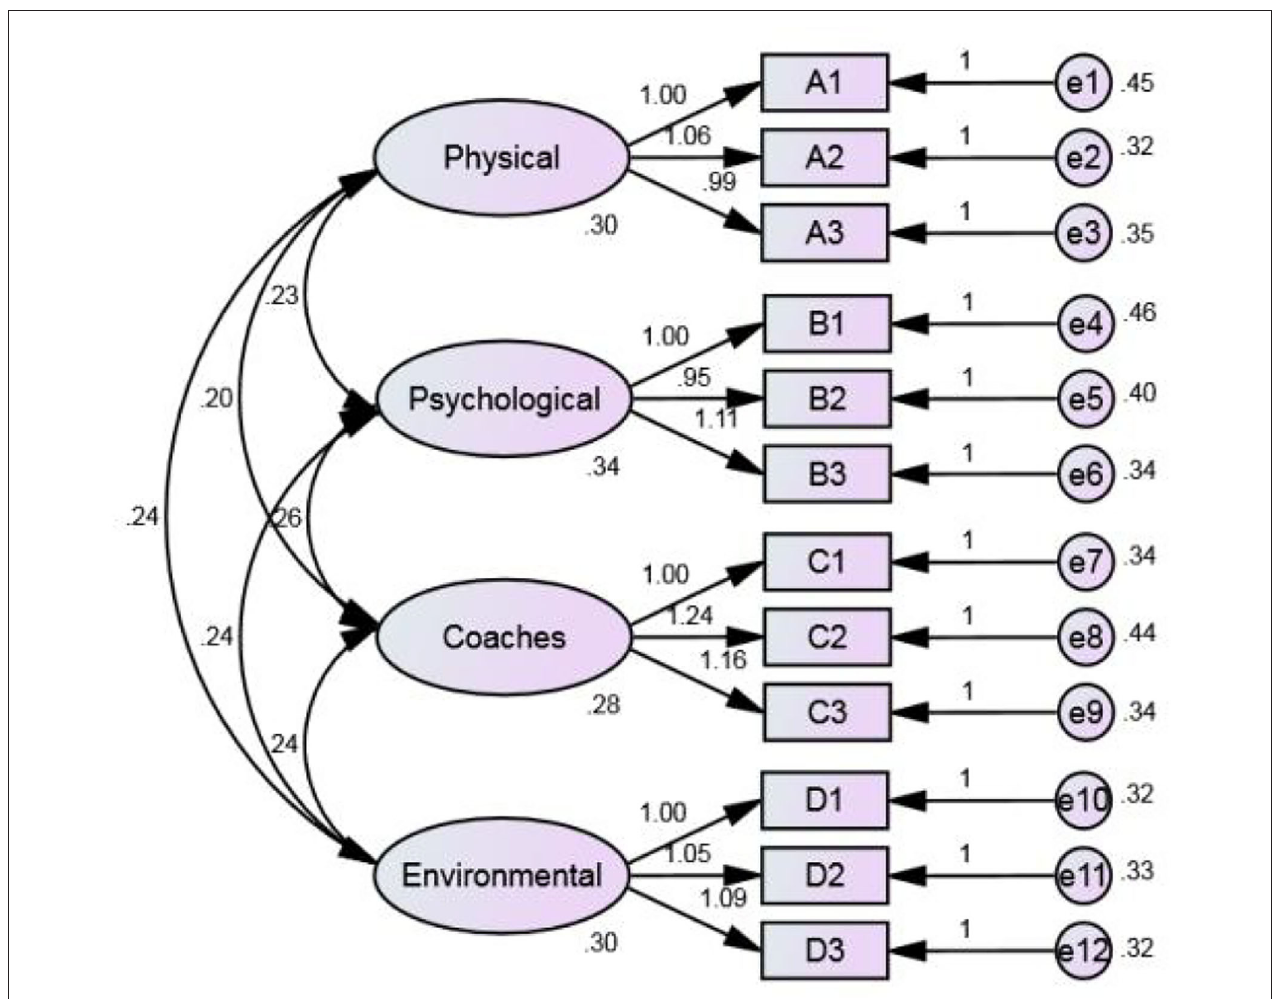
FIGURE 4 | Unstandardized